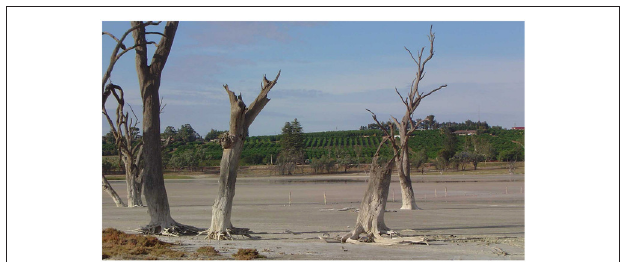
FIGURE 9 | The recent salinization of Ramco Lagoon in South Australia is clear owing to the presence of dead River Red Gum ( Eucalyptus camaldulensis ) and fringing sedge ( Cyperus sp.). The irrigation of crops on soils overlying Miocene limestone has driven an increased salt flux to the